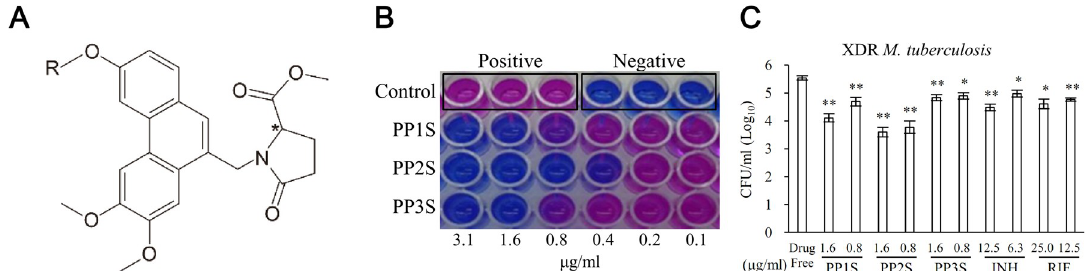
Fig 1. Structures of PPs and their inhibitory activities against M . tuberculosis . (A) PP derivatives are composed of PP1S, PP2S, and PP3S in which the alkoxy R group has a methyl group, a butyl group, and a benzyl group, respectively. (B) Inhibitory effect of S-form PPs on M . tuberculosis H37Rv were evaluated by resazurin microtiter assay. (C) Antitubercular effects of PPs on XDR M . tuberculosis (KMRC 00203–00197) were confirmed through CFU enumeration assay. Data are presented as mean ± SD. Student t test was used to compare groups ( � p < 0.05, �� p < 0.01). CFU, colony-forming units; PP, methyl (S)-1-((3-alkoxy-6,7-dimethoxyphenanthren-9-yl) methyl)-5-oxopyrrolidine-2-carboxylate; XDR, extensively drug-resistant. Data underlying this Figure can be found in S1 Data.